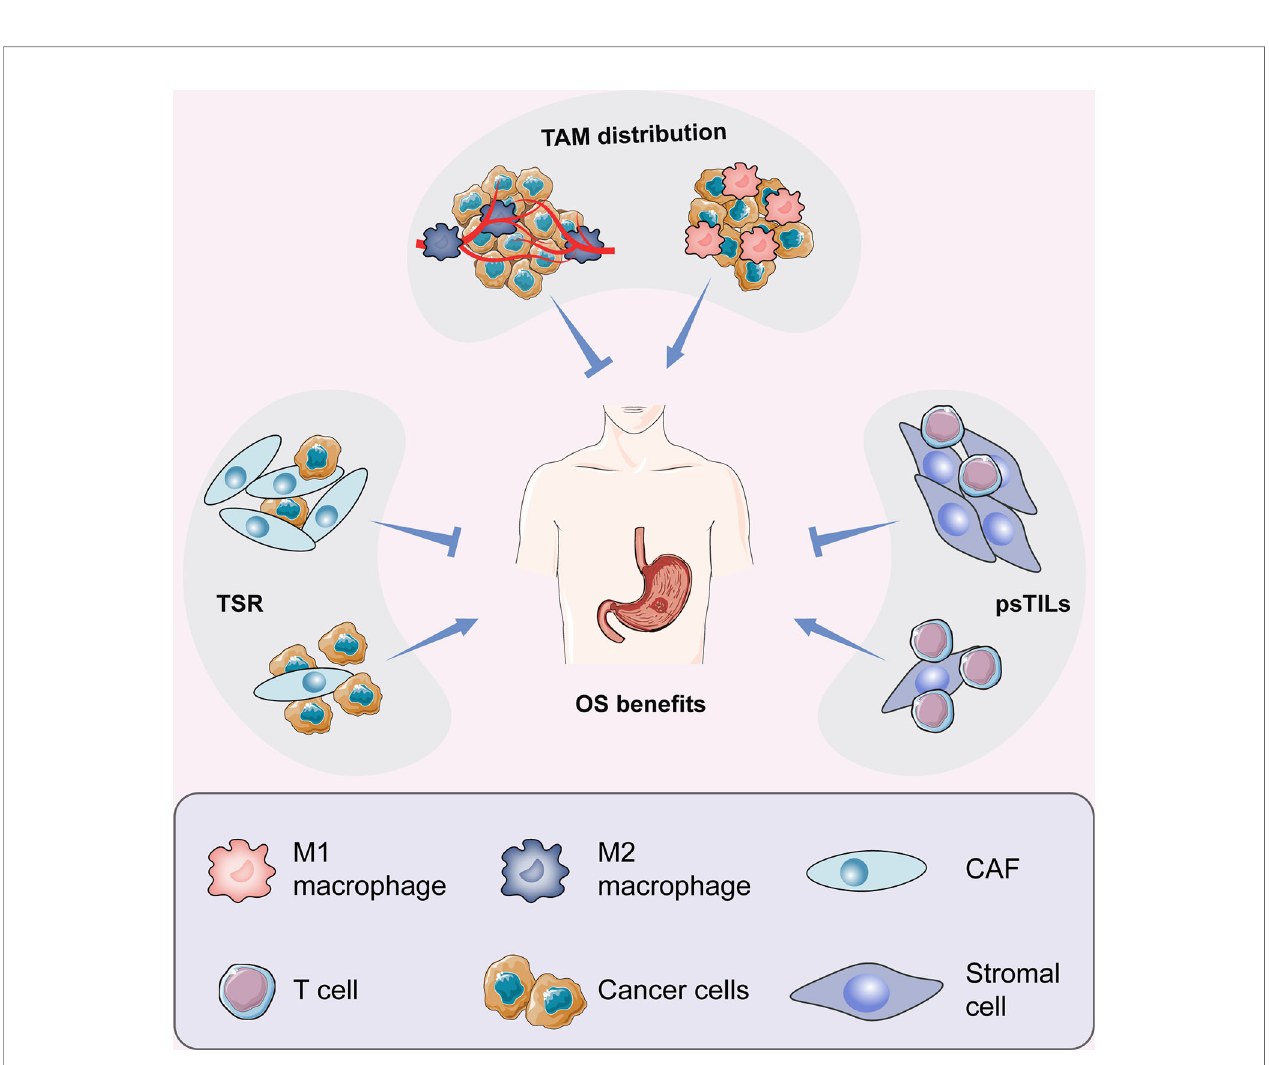
FIGURE 2 | Prognostic prediction for CAFs, TAMs, and TILs in GC.